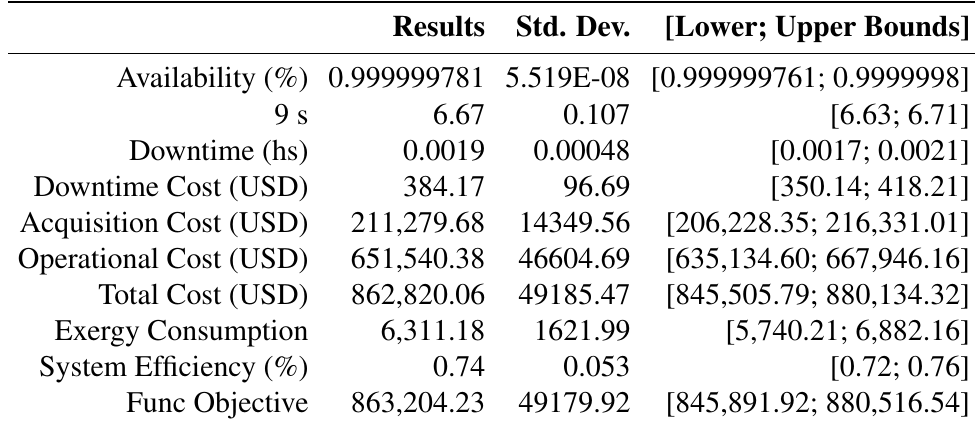
Table 7. Summary